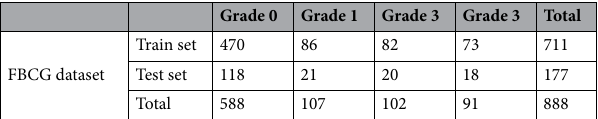
Table 4. This table shows the image distribution of the FBCG dataset.